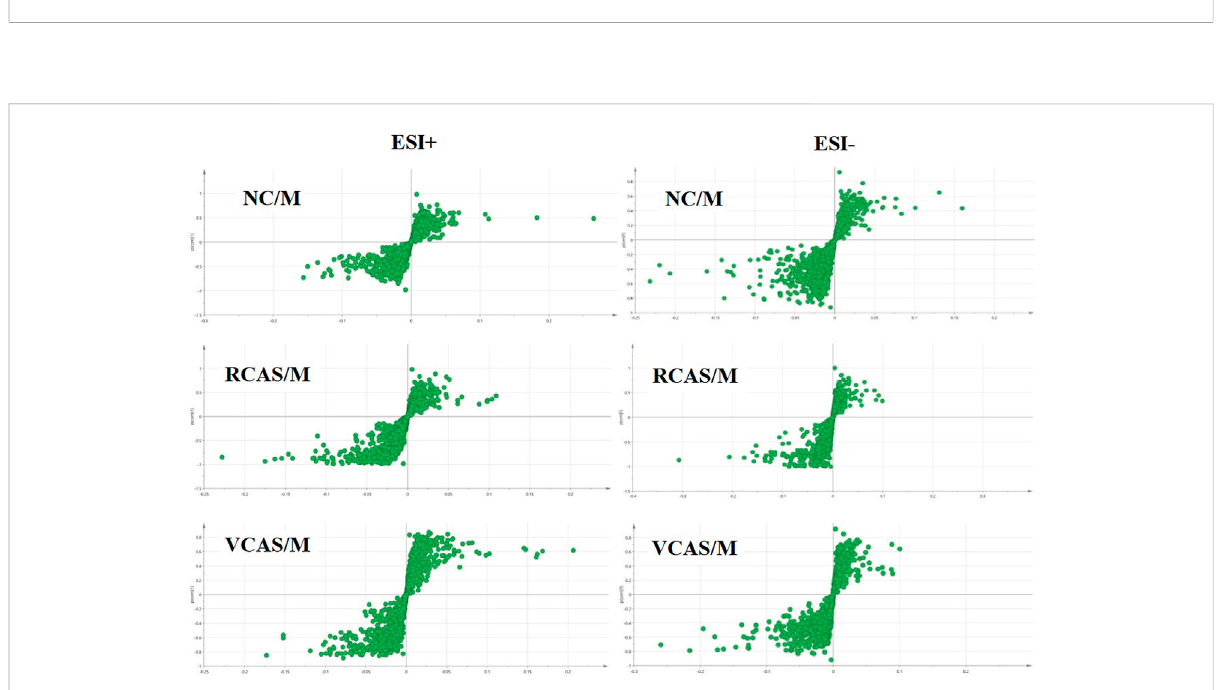
FIGURE 7 S-plot from urine samples in the positive and negative ion